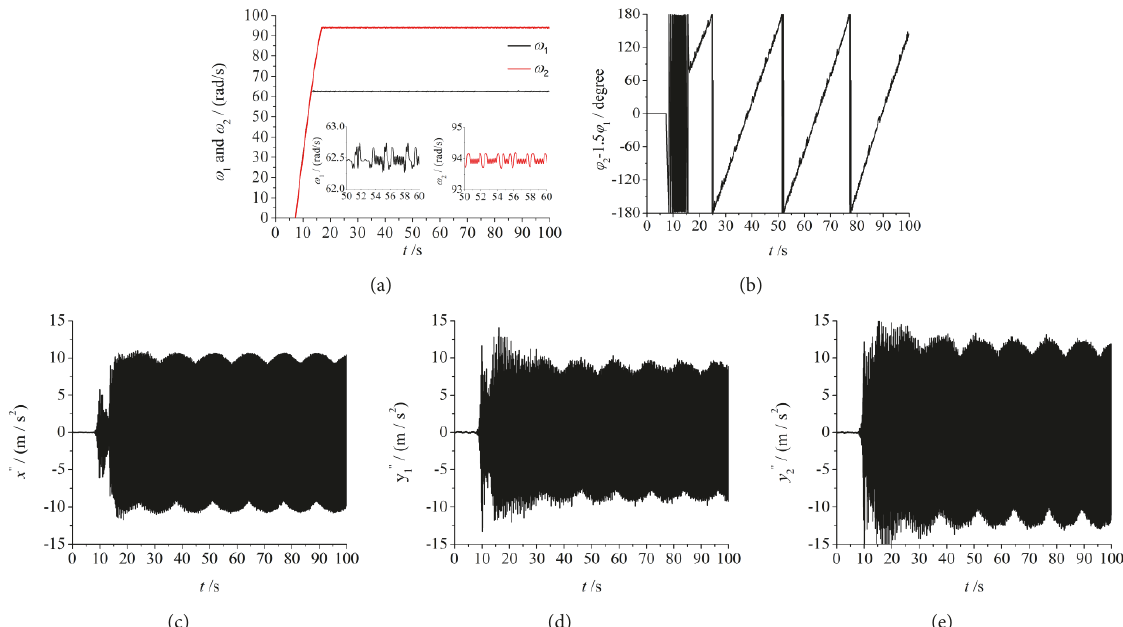
Figure 10: The experiment of the multifrequency self-synchronization, where 𝜂 = 50 % and 𝛼 0 = 0 . (a) The speed of the two motors. (b) The phase difference. (c) The response of the 𝑥 direction. (d) The response of the 𝑦 1 direction. (e) The response of the 𝑦 2 direction.